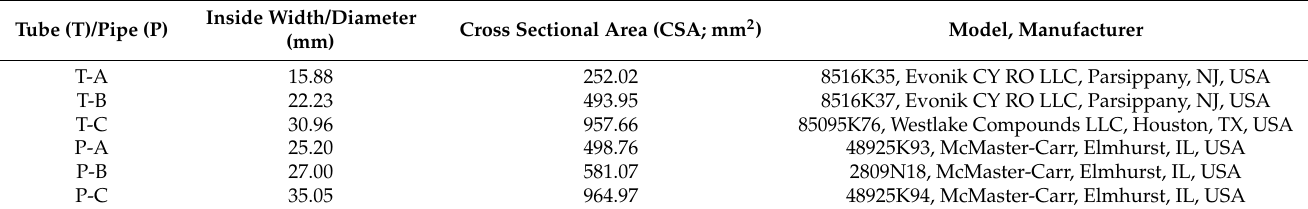
Table 1. Tubes and pipes selected to evaluate the ultrasonic sensor